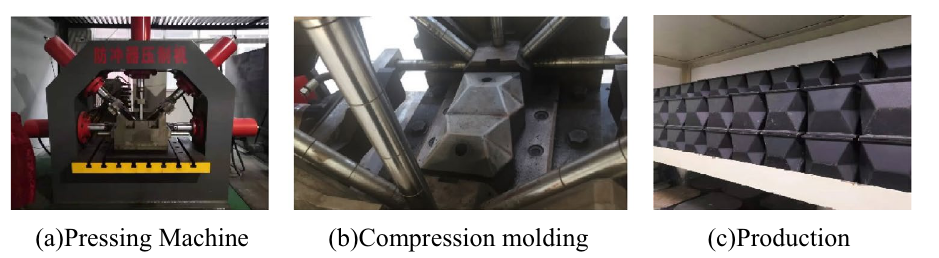
Figure 4. Production of pre folded square tube for energy absorbing